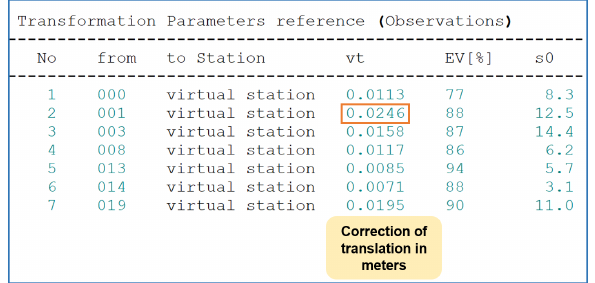
Figure 8. Section of the Scantra protocol In the graph in Figure 9, these deviations are shown with cor- respondingly bold lines. The virtual station indicates the pos- ition of the BIM origin after co-registration. Additionally the protocol lists the datum-depended standard deviations for each station and the reliability as partial redundancies.